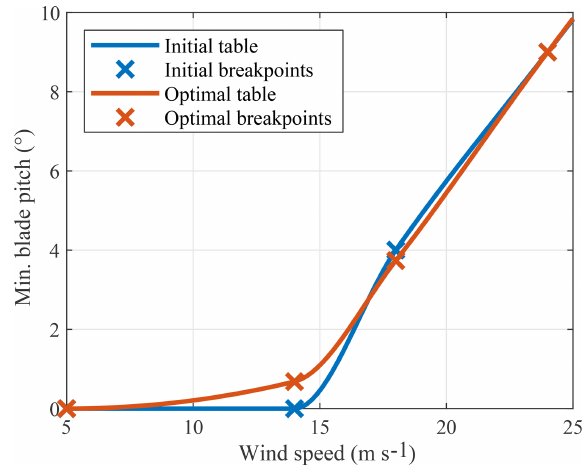
Figure 8. Minimum pitch setting as a function of wind speed. Each active breakpoint is tuned in a series of one-dimensional parameter optimizations. There is an additional high wind speed breakpoint at 50ms − 1